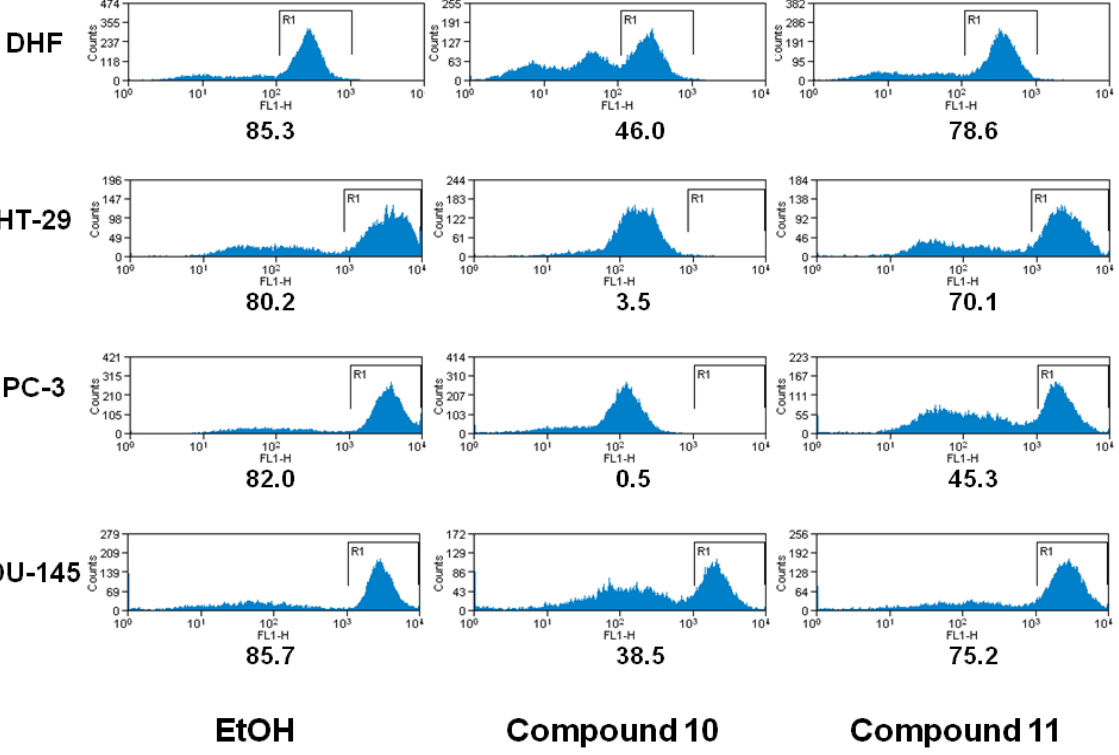
Figure 5. ent -Cyclozonarone [(+)- 10 ] and 11 treatment-induced changes in the mitochondrial membrane permeability in HDF, HT-29, PC-3 and DU-145 cells. The cells were stained with rhodamine 123, and then analyzed by flow cytometry. Representative histograms show changes in mitochondrial membrane permeability in DU-145, HT-29, PC-3 and DHF cells. The values indicate the percentages of the rhodamine 123 stained cells treated without or with the compounds (+)-10 or 11 (25 μ M). (* p < 0.05 or ** p < 0.001 vs . control treated